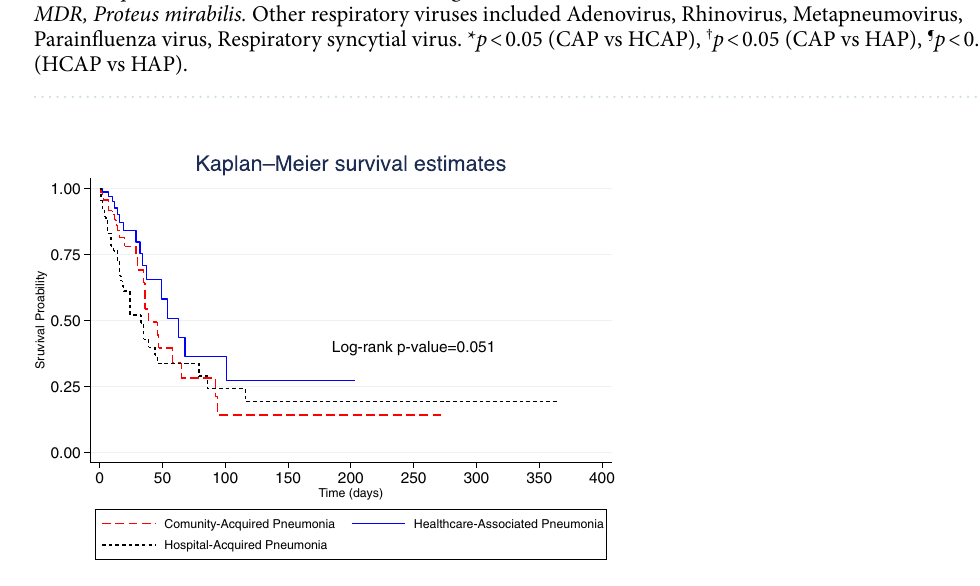
Figure 1. Kaplan–Meier graph of inhospital mortality by pneumonia